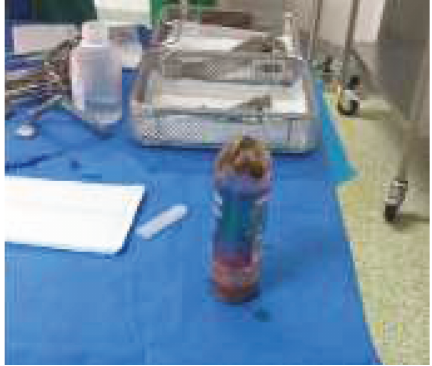
Figure 3: Surgically extracted rectal foreign